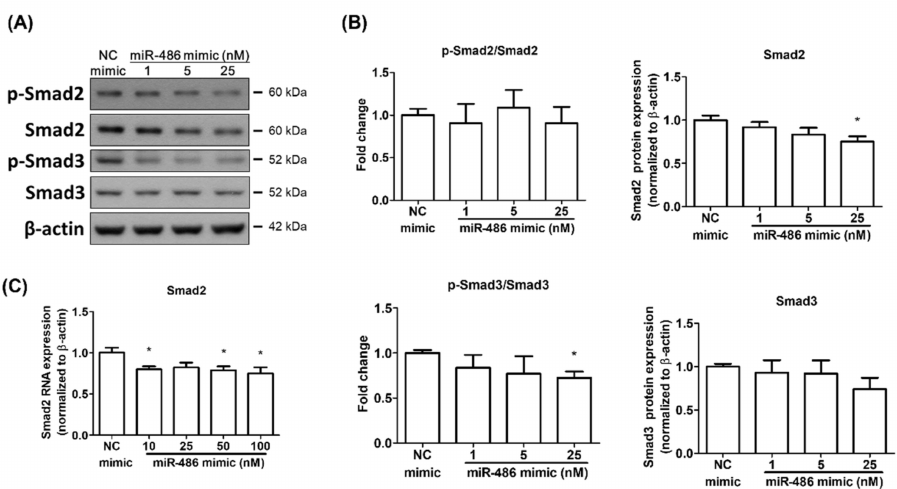
Figure 3. miR-486-5p downregulated Smad2 and Smad3 in HPASMCs. ( A ) HPASMCs were trans- fected with the miR-486-5p mimic or NC mimic, and the total mRNA and cell lysate were